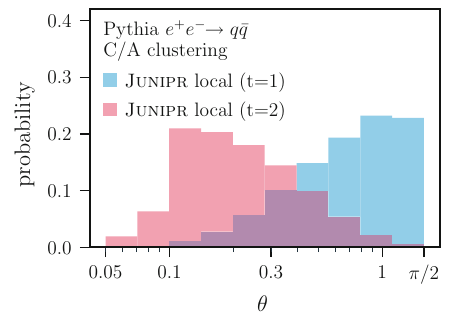
and this local model is clear. Not shown is the result using our baseline (global) model, which agrees perfectly with Pythia , as expected from